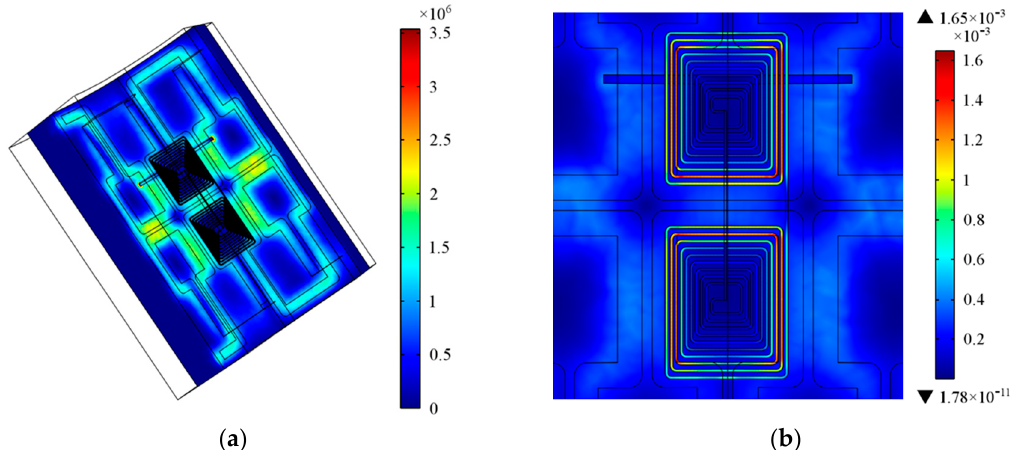
Figure 4. ( a ) Distribution of the eddy current density (A/m 2 ), f = 1MHz; ( b ) Distribution of the magnetic flux density (T), f = 1 MHz.